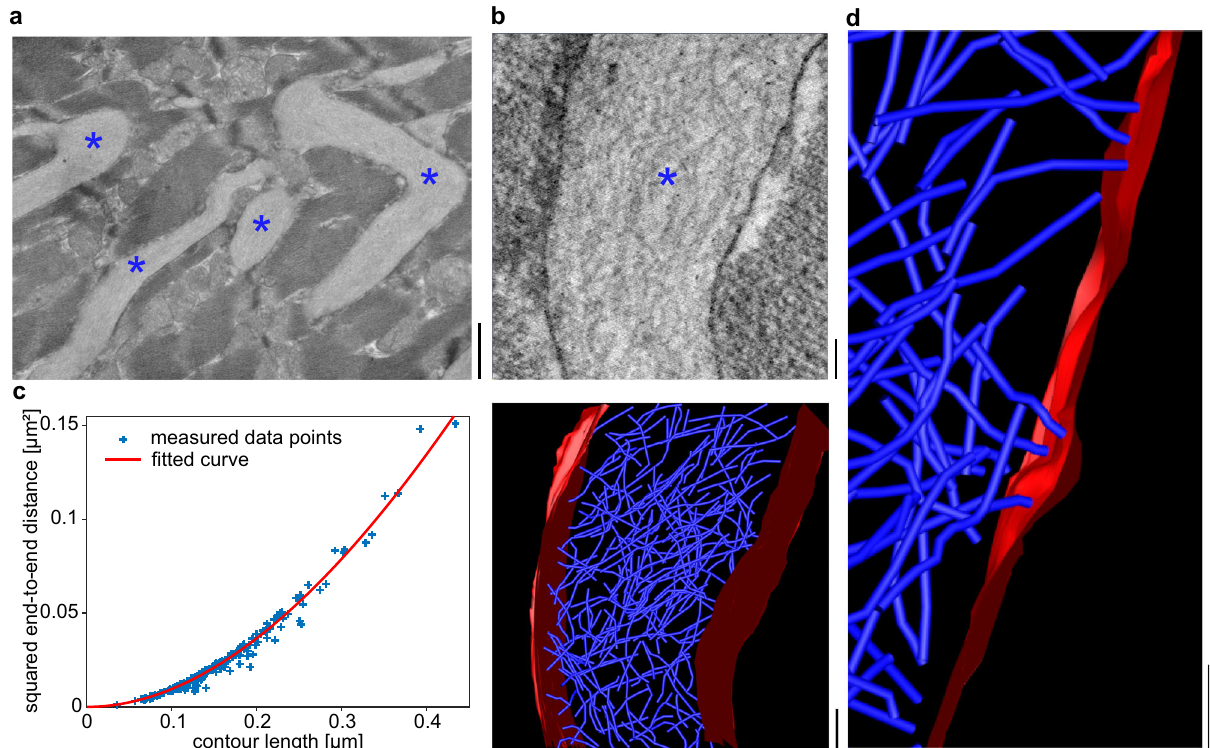
Fig. 1 Tissue deposits of FOR001 amyloid fi brils. a SEM overview of FOR001 heart tissue. The fi bril deposits between cardiomyocytes are marked with blue asterisks. Scale bar: 1 μ m. b STEM tomogram. Top: virtual section. The fi bril deposit is marked with a blue asterisk. Bottom: rendered tomogram of the fi bril deposit. Blue: amyloid fi brils. Red: membranes. Scale bar: 100 nm. c Analysis of the persistence length based on a fi t of the plot showing the squared end-to-end distance versus the contour length using Eq. (1). The blue symbols show the measured data points ( n = 195) and the red line the fi t. d Region of the tomogram, showing the interactions of the fi brils (blue) with the cardiomyocyte membrane (red). Scale bar 100